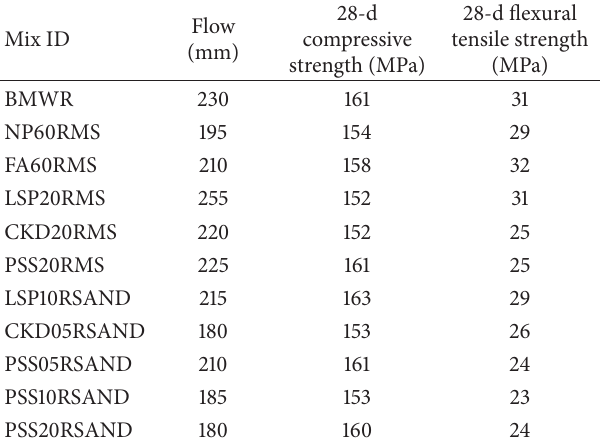
Table9:SelectedUPHCmixturesmeetingthecriteriaforminimum required flow (180mm) and 28-d compressive strength